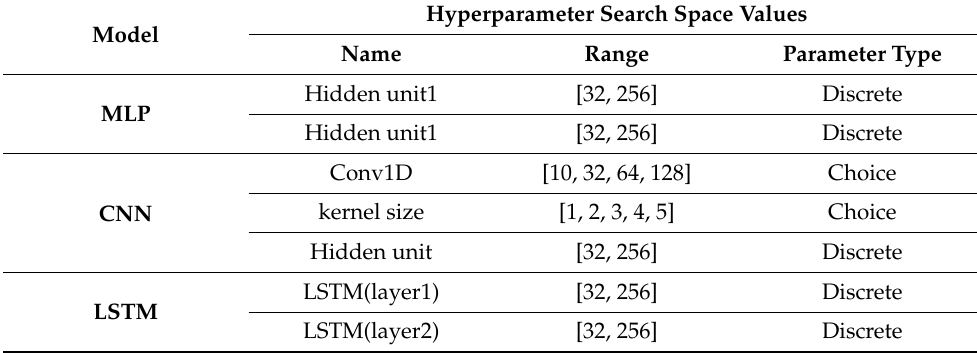
Table 1. Hyperparameter search space of three machine learning models.